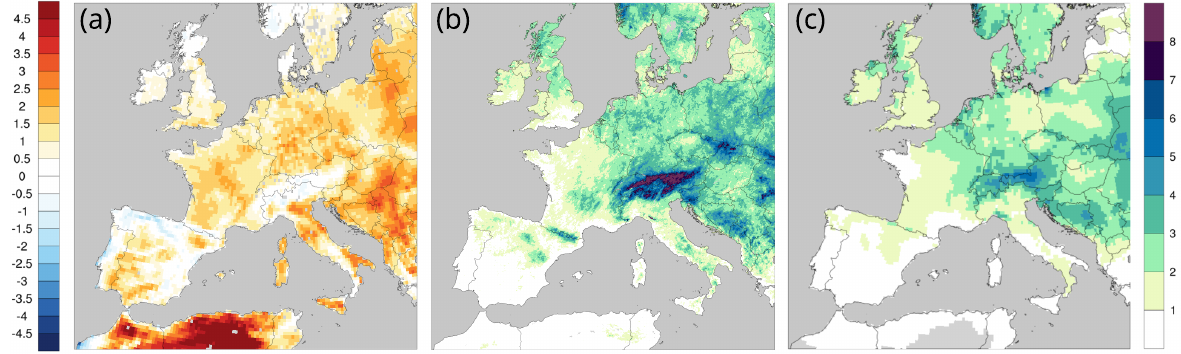
Figure 7. Validation of CTRL2 seasonal means: (a) temperature bias [K], (b) simulated precipitation [mmday − 1 ], and (c) observations from E-OBS. To account for differences in topography and spatial resolution the model 2m temperature has been height corrected assuming a lapse rate of 0.65K/100m, before calculating the